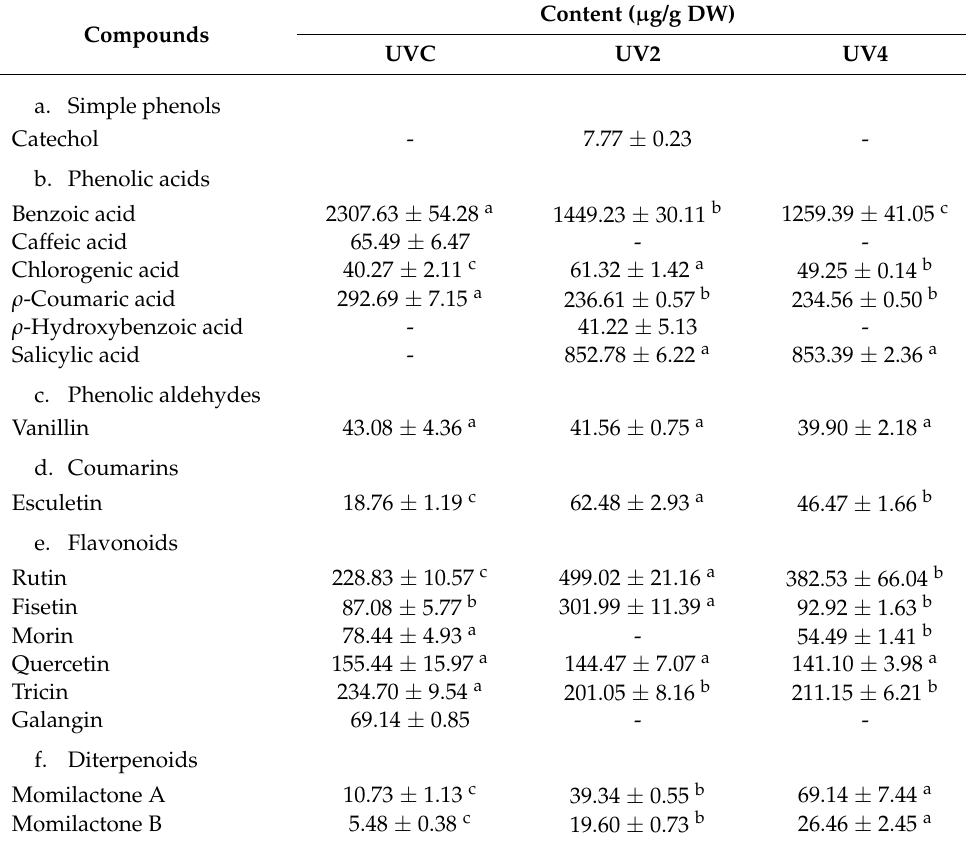
Table 2. Changes in chemical contents of rice seedlings in response to UV